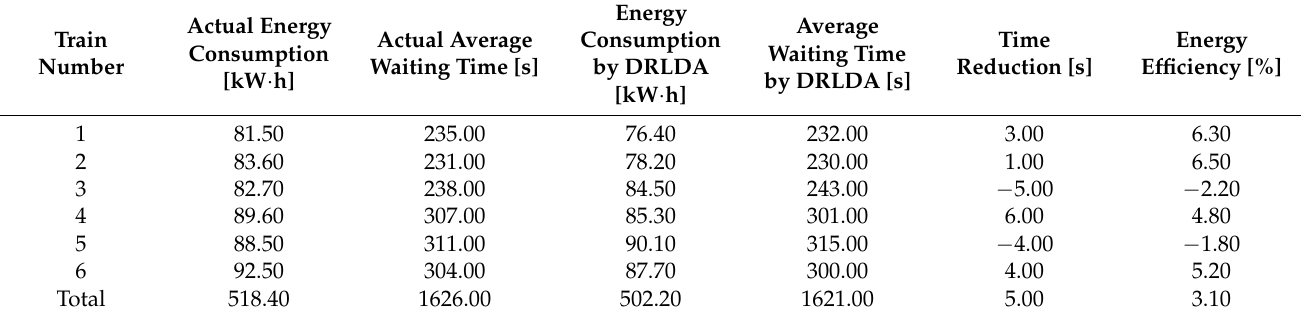
Table 10. Comparison